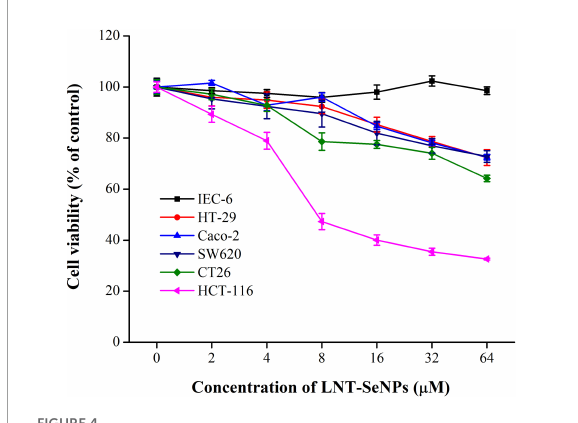
FIGURE4 The cytotoxicity of LNT-SeNPs in colon cancer (HCT-116, HT-29, Caco-2, SW620, and CT26) and normal cells (IEC-6) at the concentration range of 2–64 µ M. Data were shown as mean values ± SD ( n =